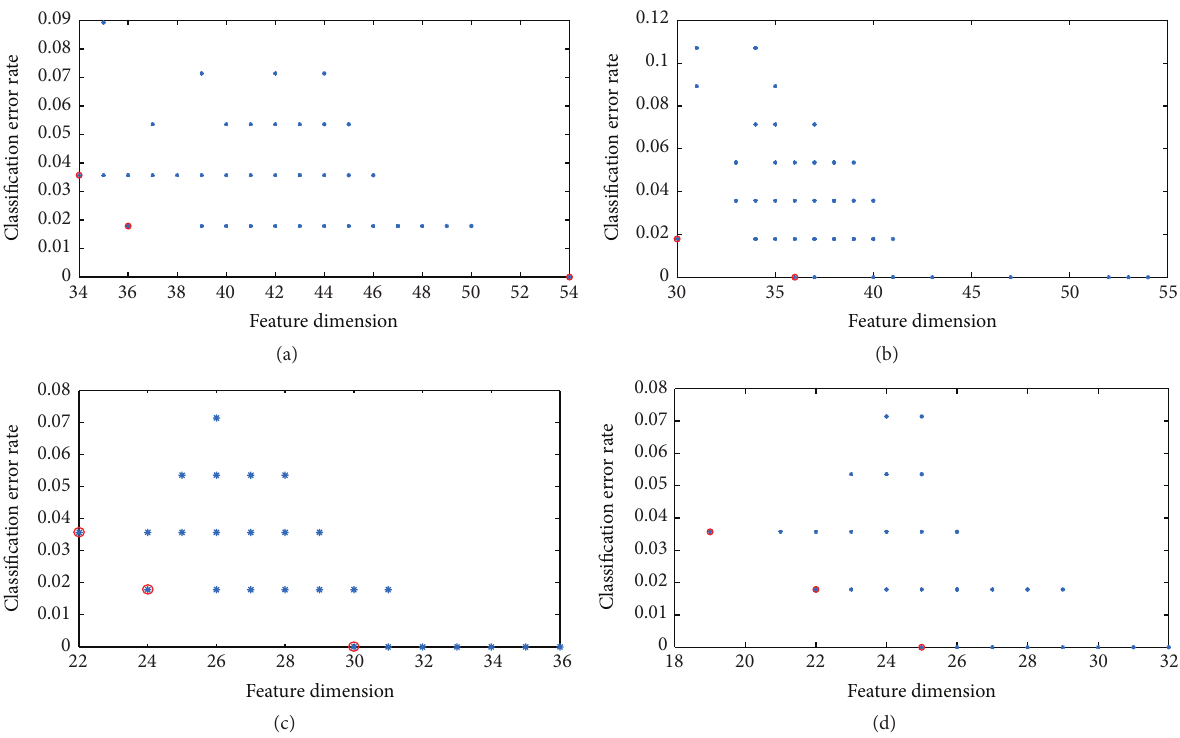
Figure 11: Distributions of the solutions at different generations over the objective plane utilizing the NSGA-II based on the original feature : (a) 10 generations; (b) 20 generations; (c) 40 generations; (d) 60 generations. subset 𝐹 Original